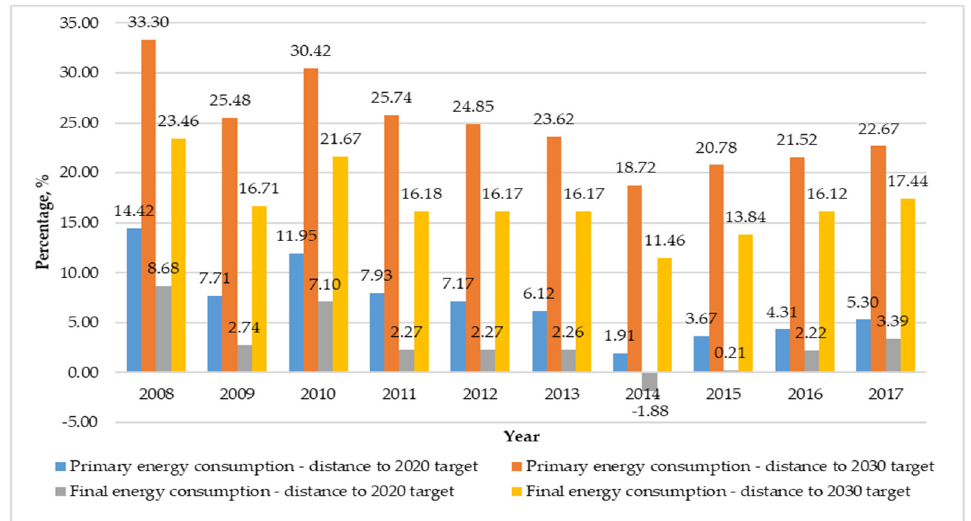
Figure 1. Distance to EU energy efficiency targets implementation, 2008–2017 (%). * 0 (zero) means that the target is reached. Source: data from [12].